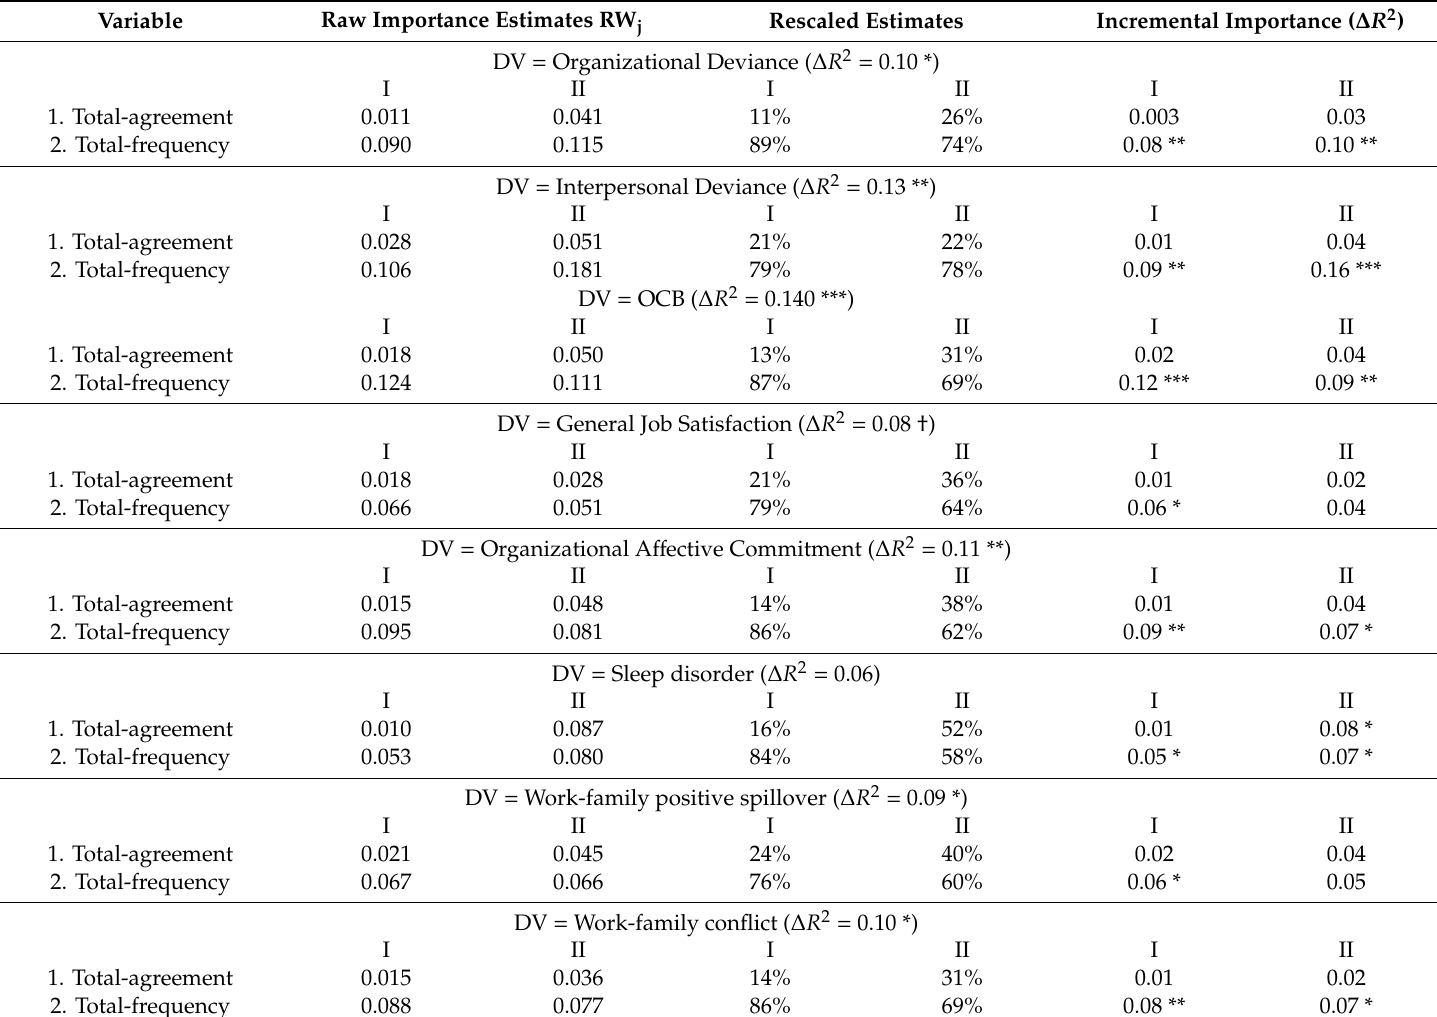
Table 5. Relative importance analysis for Sample 2 Surveys I and II ( N =